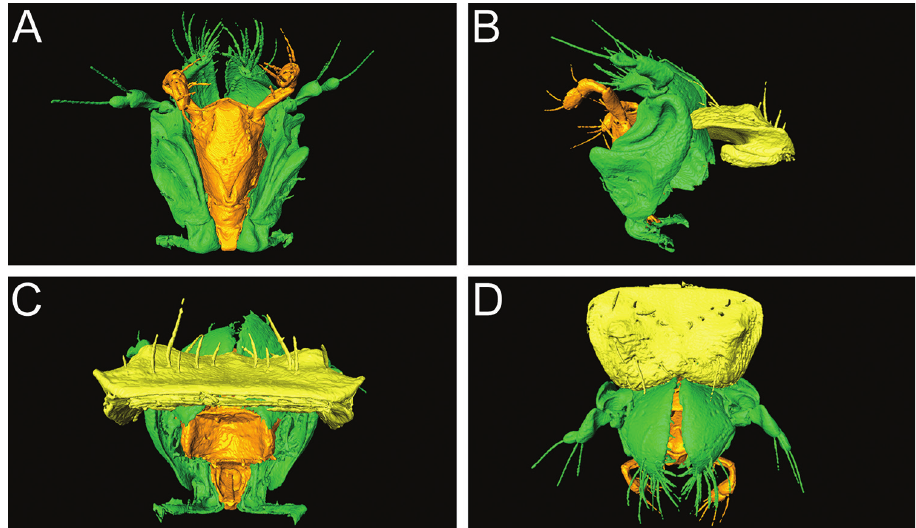
Figure 14. Volumetric 3D model of segmented surface reconstructions of the mouthparts of Zas- phinctus sarowiwai sp. n. (CASENT0764652) in open configuration (green=maxillae; yellow=labrum; orange=labium). A Frontal view B Lateral view C Posterior view D Dorsal